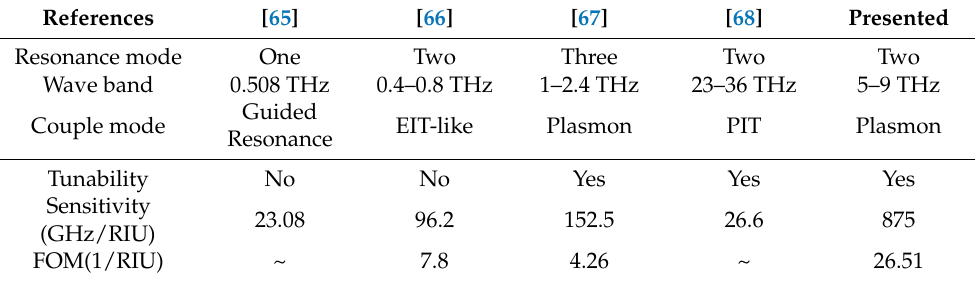
Table 1. Comparison of various performance of similar absorption sensors.